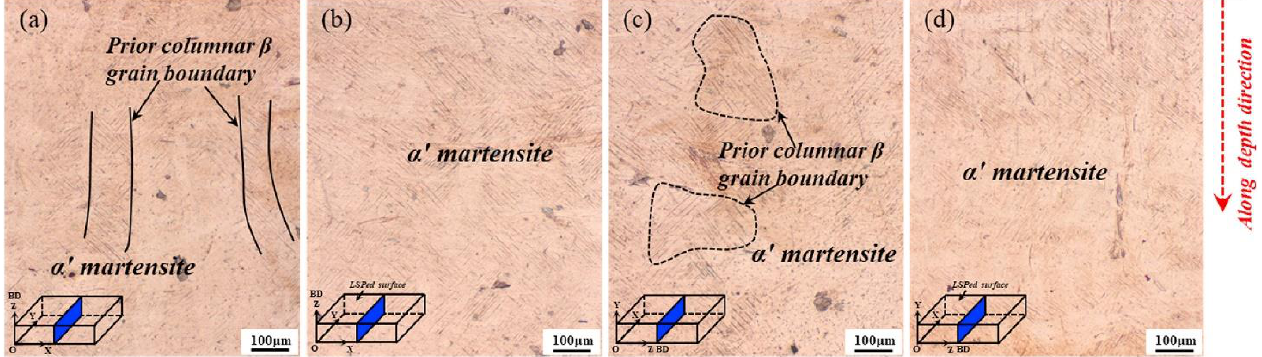
Figure 13. Optical images of Ti6Al4V samples’ cross -sections: horizontal ( a ) AM and ( b ) AM-LSP specimens, and vertical ( c ) AM and ( d ) AM-LSP specimens [74]; with permission from Elsevier.